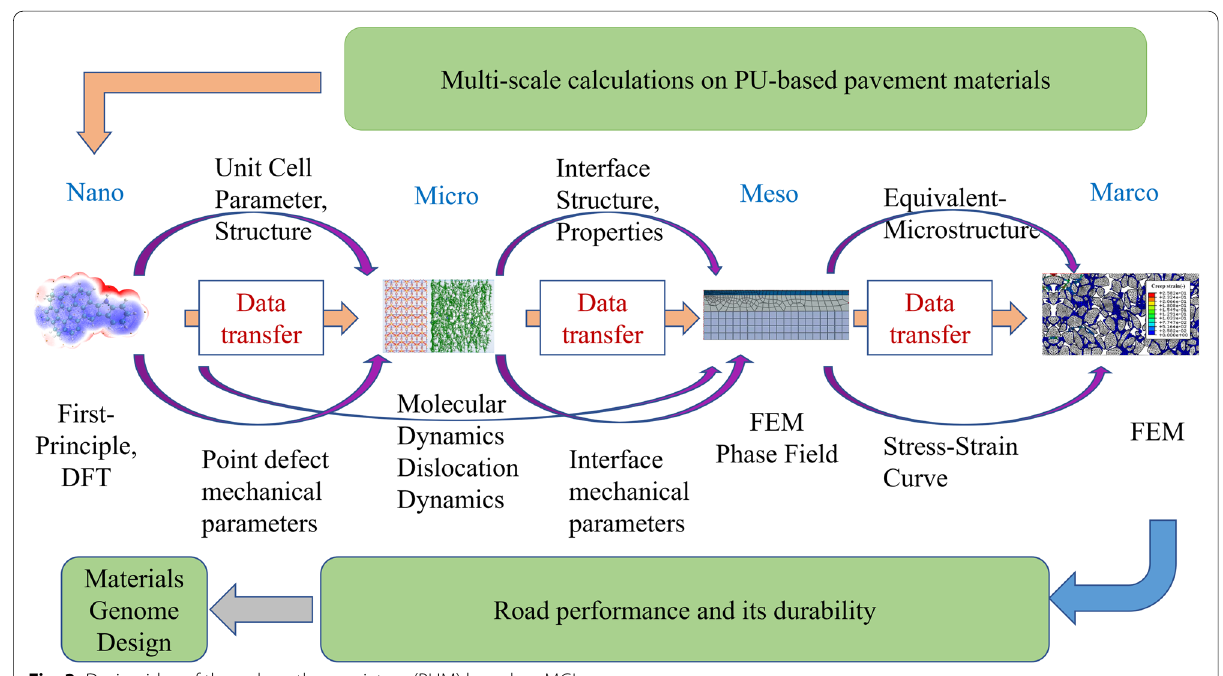
Fig. 3 Design idea of the polyurethane mixture (PUM) based on